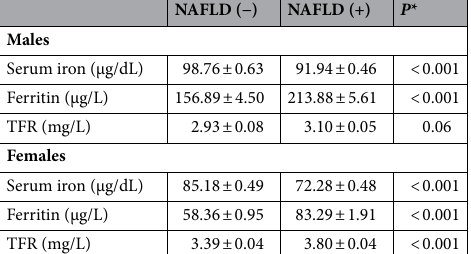
Table 3. Iron status according to the presence of NAFLD. NAFLD (−), participants without NAFLD; NAFLD (+), participants with NAFLD; NAFLD non-alcohol fatty liver disease, TFR transferrin receptor *Unadjusted P